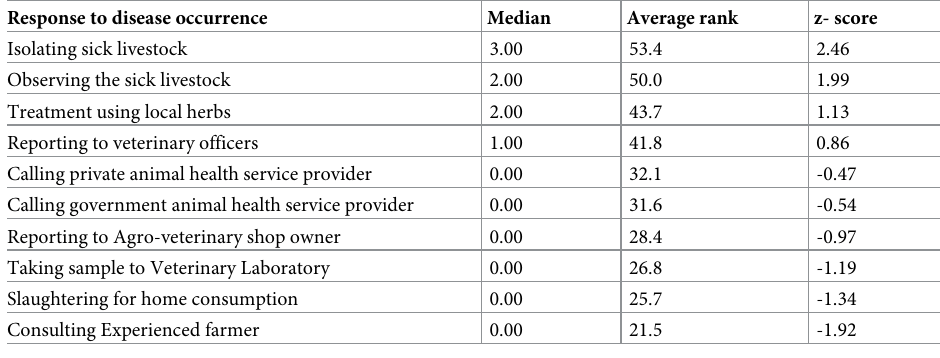
Table 2. How Participants would respond to the Occurrence of Diseases, Nakuru, 2020. Response to disease